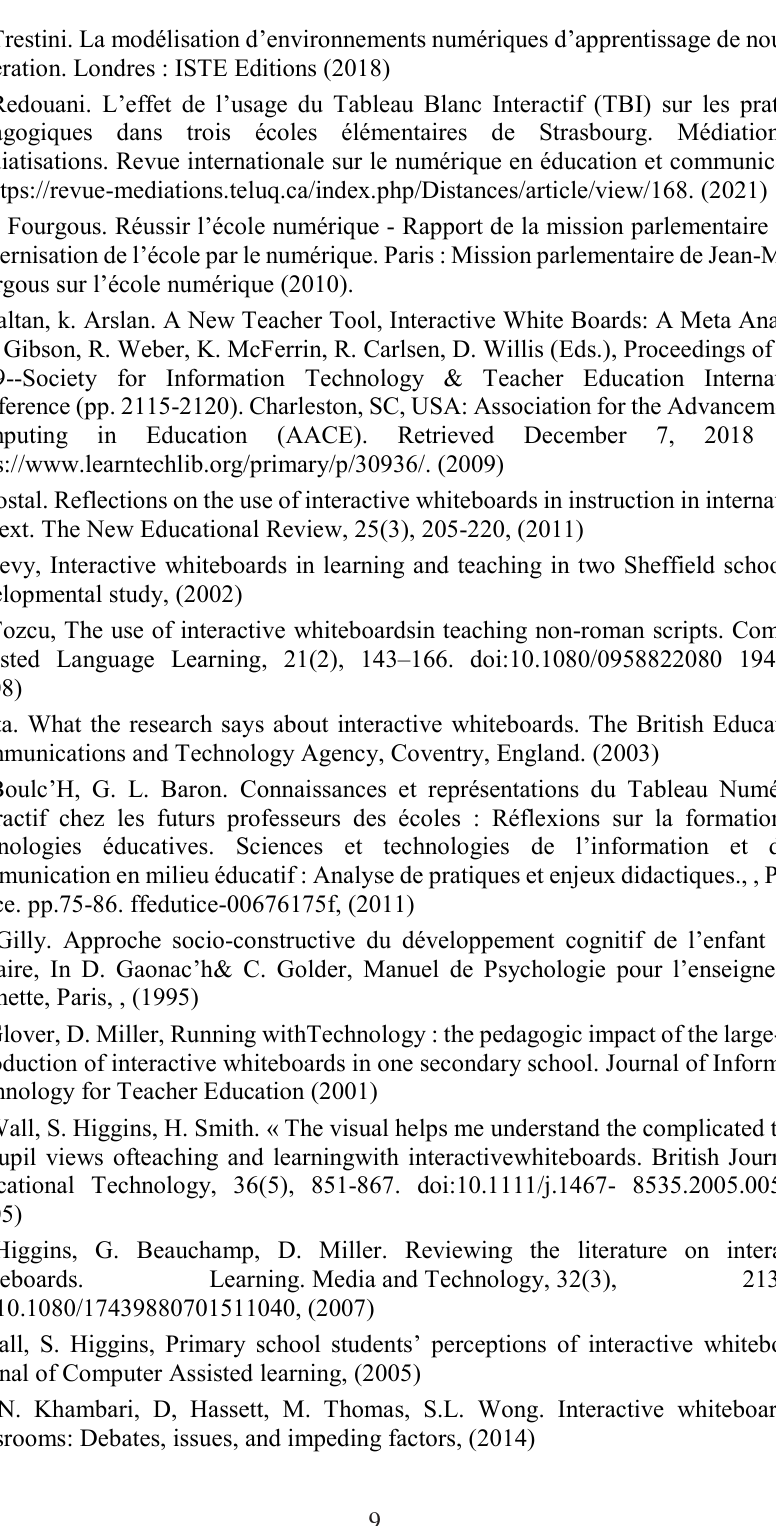
Fig. 4 La perception par les élèves de l’impact du TBI sur leurs résultats en